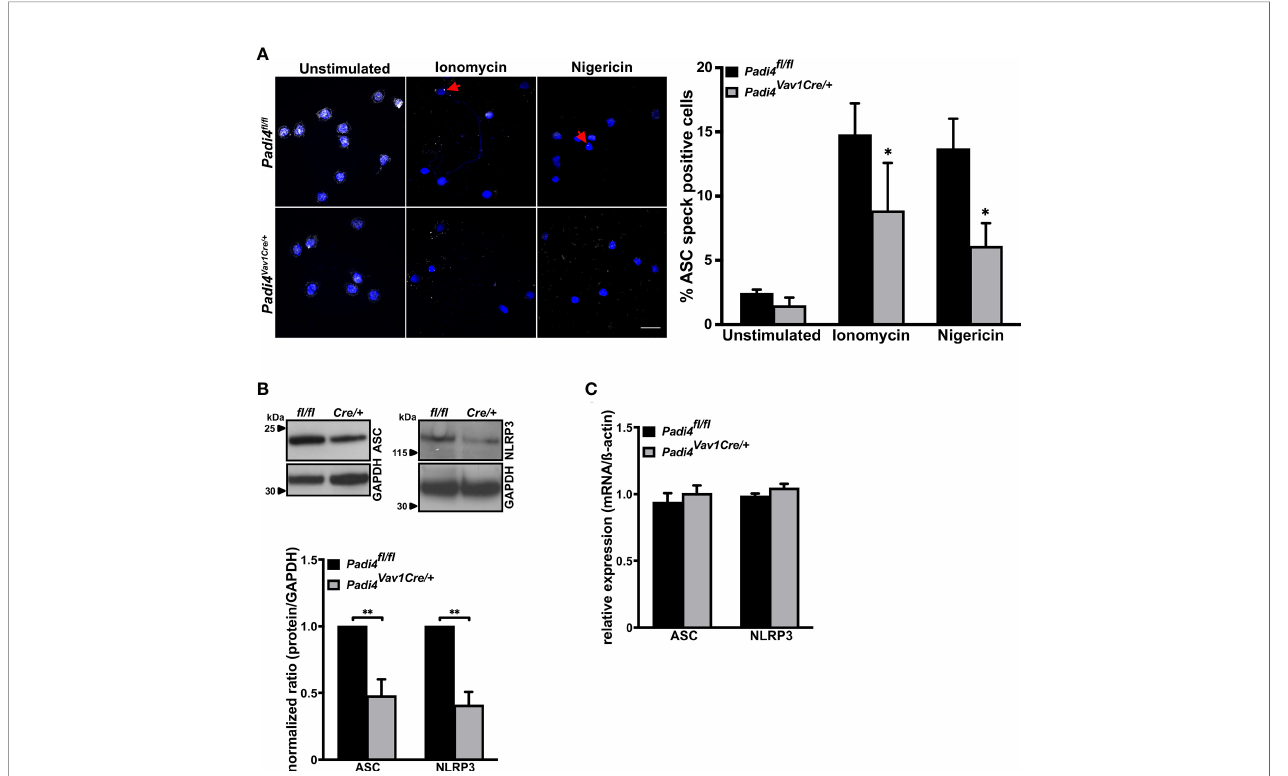
FIGURE 2 | ASC speck formation in neutrophils is, in part, directed by PAD4-dependent regulation of ASC and NLRP3 protein levels (A) Representative confocal microscopy images (left panel) and arithmetic means ± SEM (right panel, n=4-6 mice) of ASC speck formation in neutrophils from wild-type ( Padi4 fl / fl , black bars) or hematopoietic cell-speci fi c Padi4-de fi cient mice ( Padi4 Vav1Cre/+ , grey bars) in the absence (unstimulated) or presence of ionomycin (4 µM) or nigericin (15 µM) for 4 hours. Blue, DNA (DAPI); grey, ASC antibody staining. Red arrows indicate ASC speck. Scale bar equals 10 µm. * p<0.05. (B) Representative western blots (upper panel) and arithmetic means ± SEM (lower panel, n=4 mice) of ASC and NLRP3 protein levels in naive neutrophils from wild-type ( Padi4 fl / fl , black bars) or hematopoietic speci fi c Padi4-de fi cient mice ( Padi4 Vav1Cre/+ , grey bars). ** p<0.01. (C) Arithmetic means ± SEM (n=3 mice) of relative mRNA levels in naive neutrophils from wild-type ( Padi4 fl / fl , black bars) or hematopoietic speci fi c Padi4-de fi cient mice ( Padi4 Vav1Cre/+ , grey